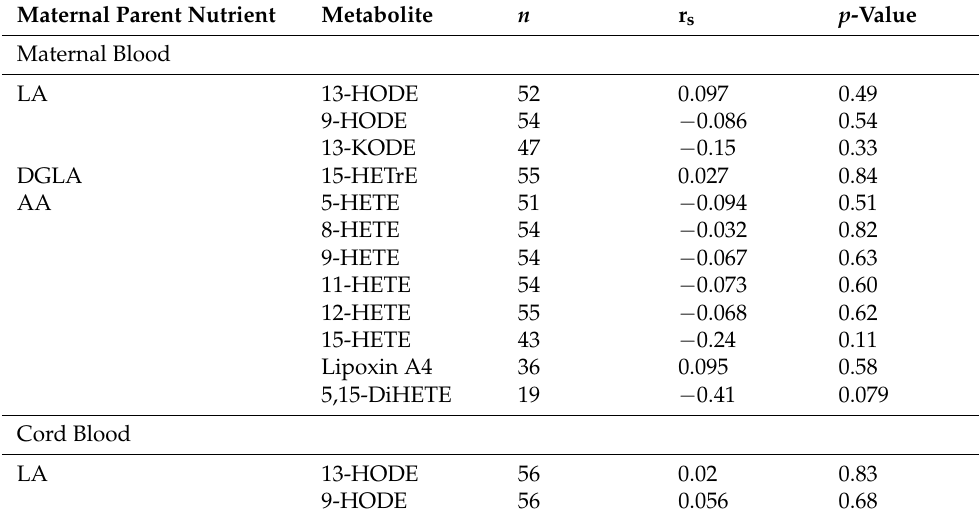
Table 4. Correlations between maternal plasma levels of omega-6 parent nutrients ( µ g/mL) and omega-6 maternal and umbilical cord metabolite